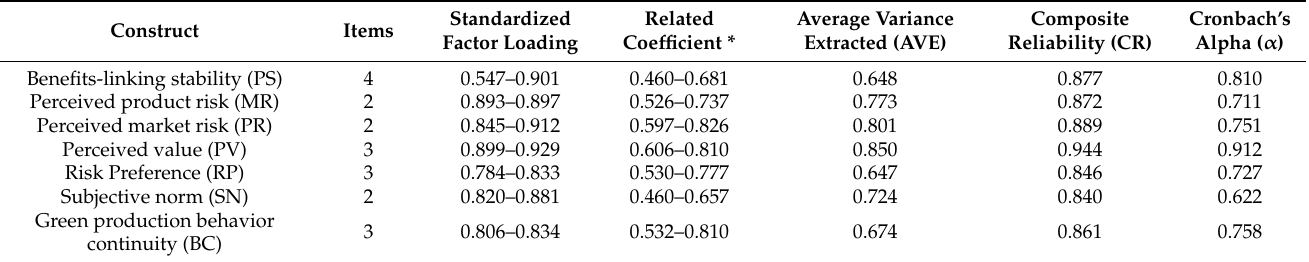
Table 6. Reliability and validity test ( N = 264) of survey